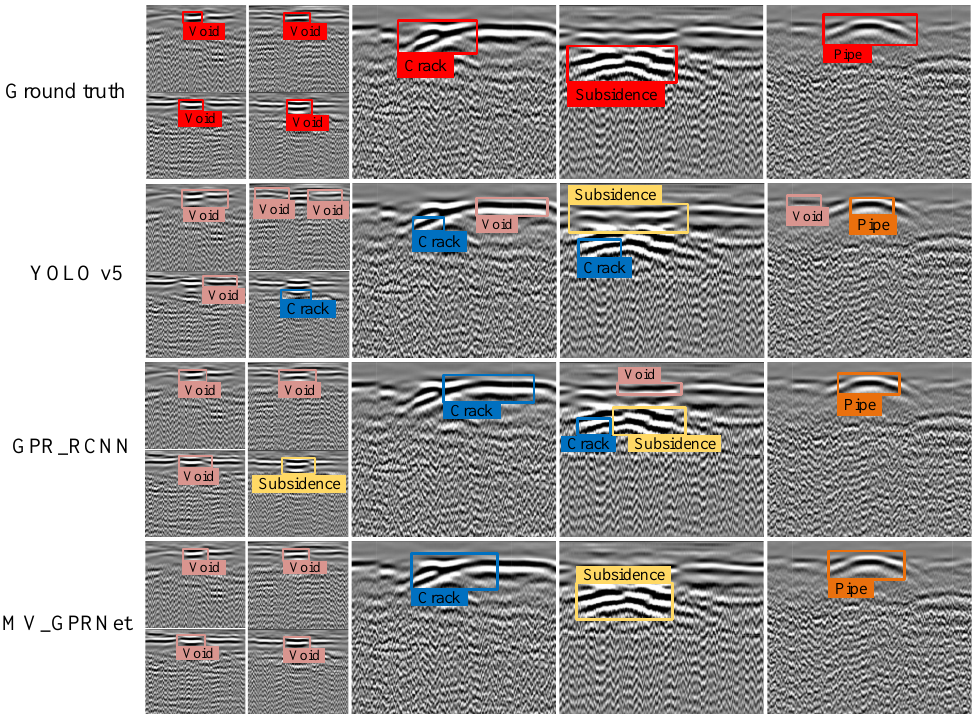
Figure 14. Representative comparison results for complex subsurface defects on B-scan image of artificial